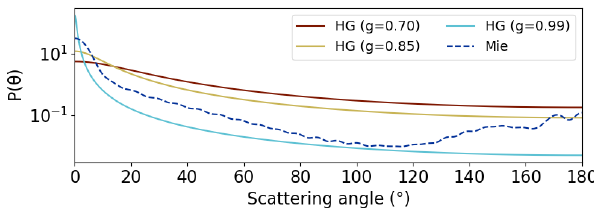
Figure B2. Comparison of different scattering phase functions P ( θ ). It shows different Henyey–Greenstein (HG) phase functions with their respective asymmetry parameter g as well as a computed Mie phase function (details see Sect. 3.1).